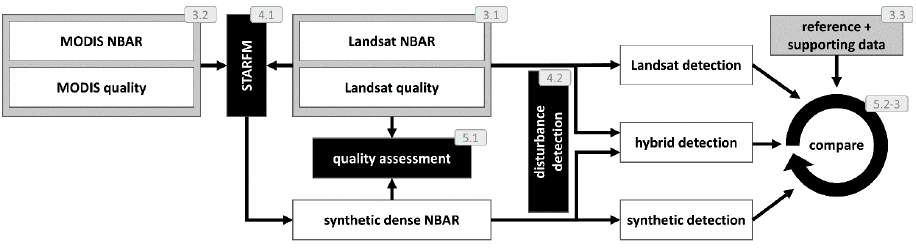
Figure 3. Schematic workflow of this study with references to the sections and sub-sections.